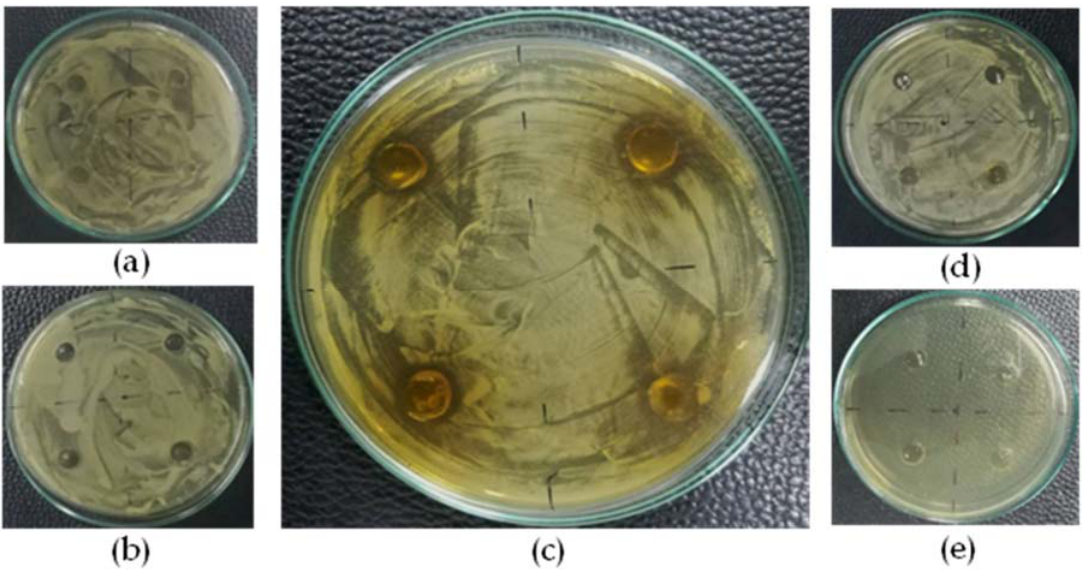
Figure 3. Photographs showing the inhibition zone of gel formulation containing the herbal ball extract at ( a ) 0.1% w / w , ( b ) 1% w / w and ( c ) 5% w / w against P. acnes when compared with that of ( d ) the placebo and ( e ) the positive control.